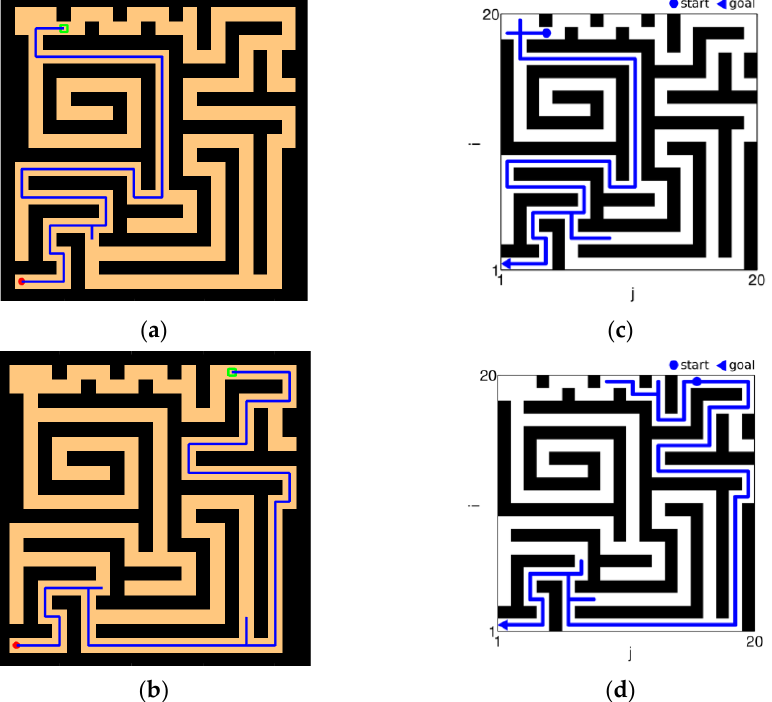
Figure 21. Results of complex maze experiments and comparison of results. ( a , b ) The results of our model navigation, where the red circles are the starting points and the green squares are the ending points. ( c , d ) The navigation results of the model provided by Khajeh-Azadeh et al. ( a ) Our result in task 1. ( b ) Our result in task 2. ( c ) Contrast result in task 1. ( d ) Contrast result in task 2.